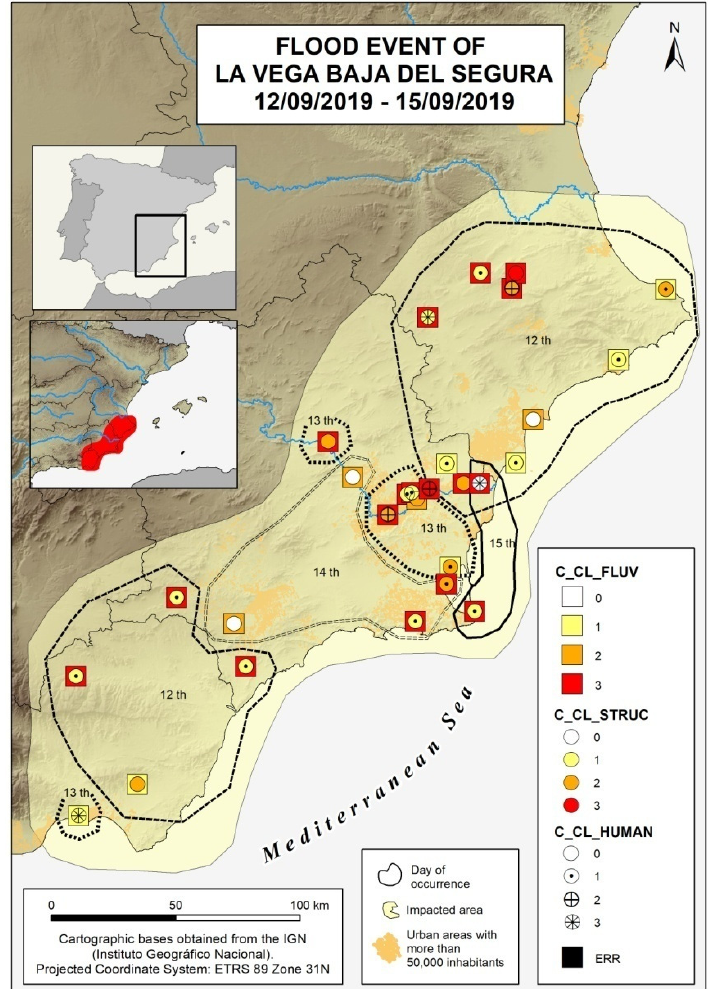
Figure 5. Representation of cases for the flood event of 12 to 15 September 2019. C_CL_FLUV: Variable 1. Hydraulic behaviour of the river flood. C_CL_STRUC: Variable 2. Flood impact on structural elements. C_CL_HUMAN: Variable 3. Social/personal vulnerability to the flood. ERR: Erroneous or spurious cases. Blue line: Basic fluvial system. Black line: Spanish Hydrographic Demarcations. Urban areas: Population according to 2022 demographic record.